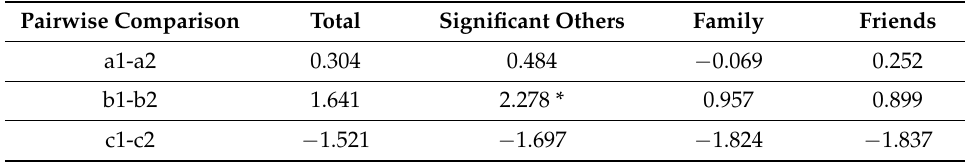
Table 4. Critical ratios for differences between pairwise parameters. Pairwise Comparison